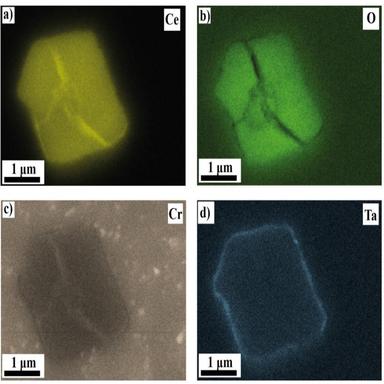
Element-specific EDX maps of the cerium-rich inclusion shown in.